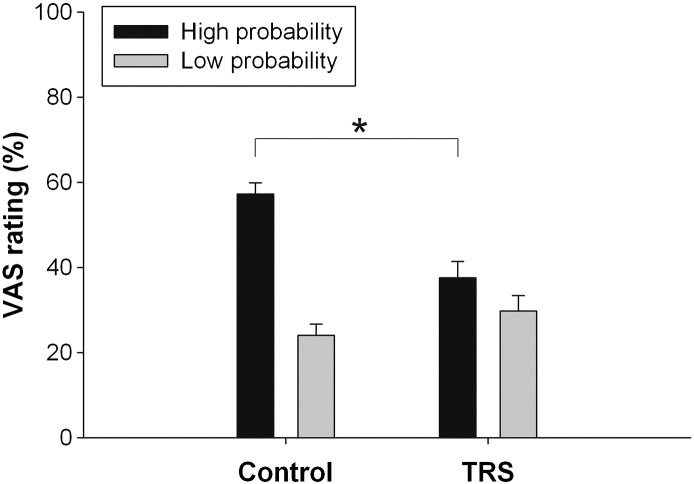
Visual analogue scale (VAS) probability ratings in schizophrenia patients with treatment-resistant delusions (TRS) and controls. Controls exhibited significantly greater explicit adaptive salience (the difference in VAS rating between high and low probability stimuli) than TRS patients [controls: mean = 33.22, SD = 21.57; patients: mean = 7.85, SD = 12.03; F(1,47) = 20.997, P < 0.001]. This group difference was driven by a reduction in the ratings for high probability stimuli in TRS patients (* indicates P < 0.001), while there was no difference between the groups for the ratings of low probability stimuli. Error bars represent standard errors of the mean.